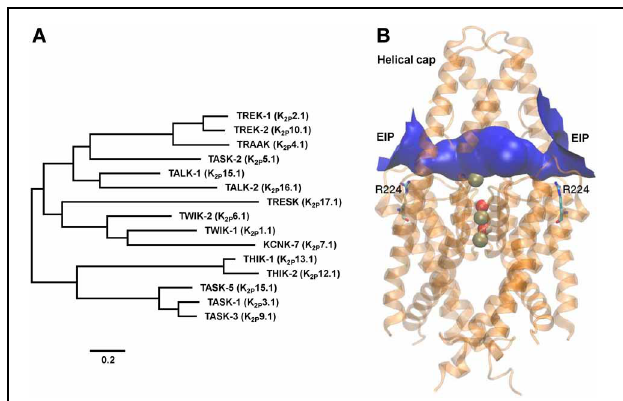
FIGURE 1 | TASK-2 position within the K 2P phylogeny and structural molecular model. (A) Phylogenetic tree constructed using human K 2P channel sequences with the MEGA5 software (www.megasoftware.net) using the maximum likelihood method. The scale bar indicates an evolutionary distance of 0.2 amino acid substitutions per position. Common and International Union of Pharmacology (Goldstein et al., 2005) names are given. (B) Modeling the extracellular ion pathway (EIP) of TASK-2 channel and the position of the R224 pH o sensors. A molecular model for the TASK-2 pore based on the structure of TRAAK (PDB ID 3UM7) is shown with both sensing R224 residues facing the EIP. Shown is a ribbon representation with K + ions and H 2 O molecules in the selectivity filter (SF). R224 pH o -sensing residues are shown in stick representation. The EIP is drawn as a solid tunnel connecting the extracellular space and the entrance of the SF. HOLE color code is used: blue, radius > 1.15 Å. The illustration is taken at the end of a 10-ns MD